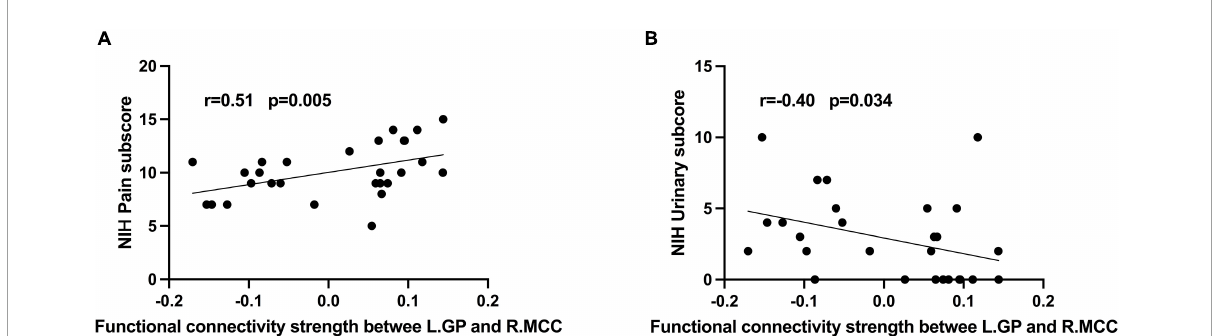
FIGURE2 Correlation analysis between (A) rs-FC of L.GP- R.MCC and NIH-CPSI pain score ( r = 0.51, P = 0.005); (B) rs-FC of L.GP- R.MCC and NIH-CPSI urinary score ( r = –0.40, P =